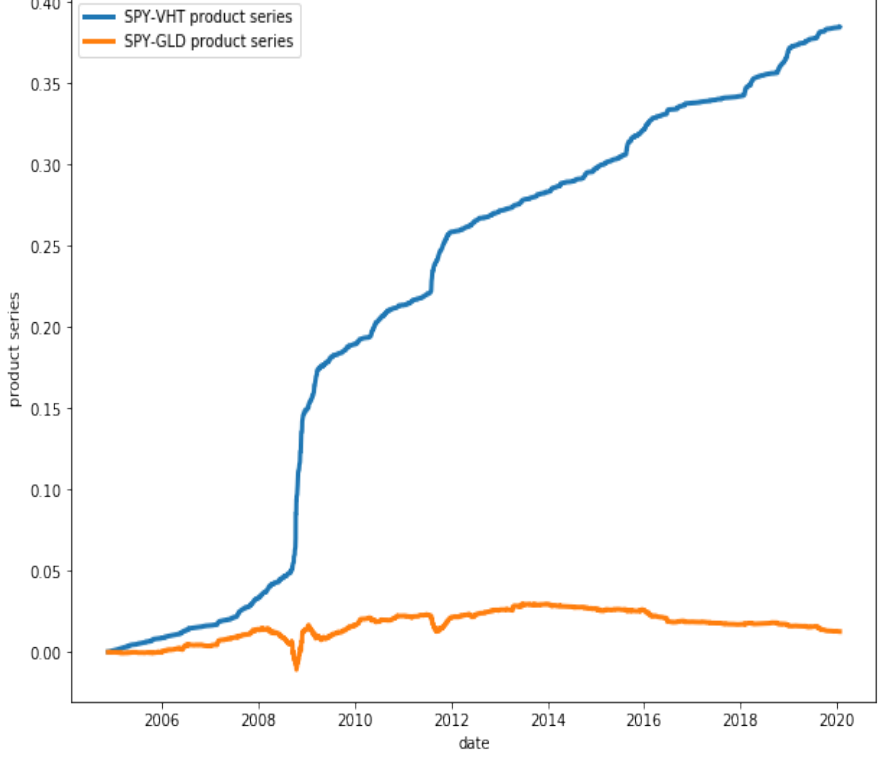
Figure 14. Product series of pairs SPY-VHT and GLD-VHT. While the product of the series of the first pair shows a clear persistence (HP = 0.998), this is not so for the second pair (HP =